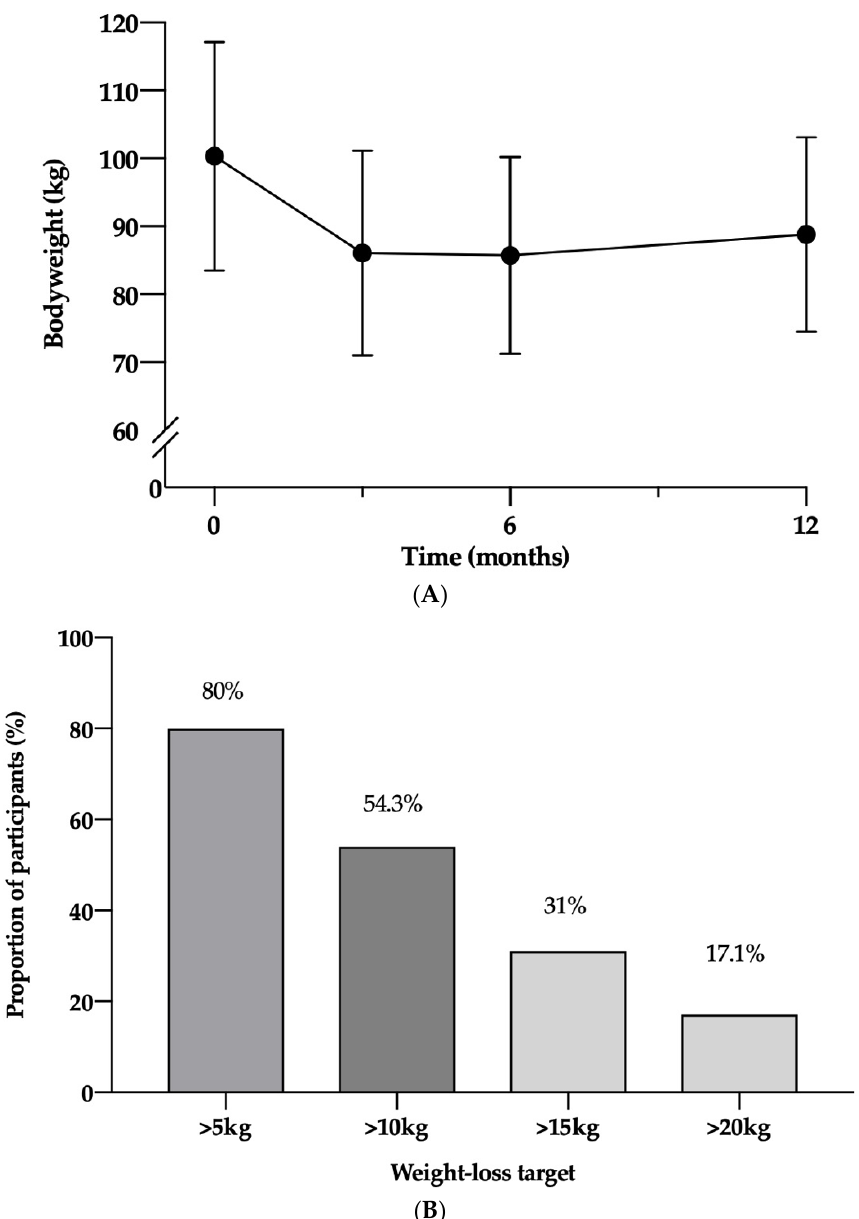
Figure 3. ( A ). Bodyweight of participants over 12 months (error bars represent 95% CIs) ( B ). Propor- tion of participants achieving key weight loss targets at 12 months. Kg, kilograms, %,